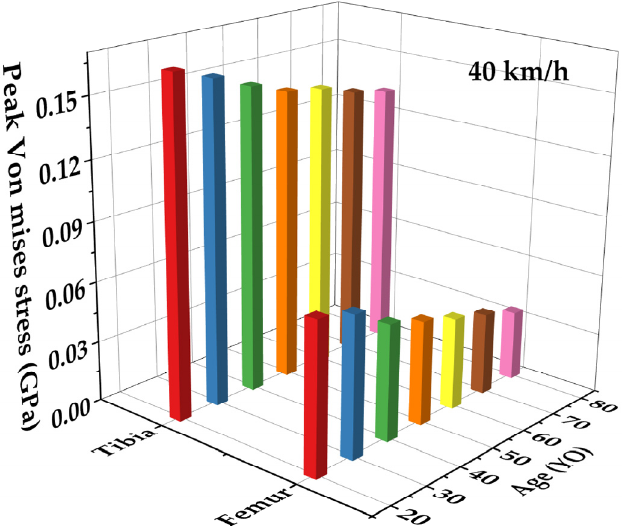
Figure 7. The peak Von mises stress of the femur and tibia of pedestrians of seven ages at 40 km/h.